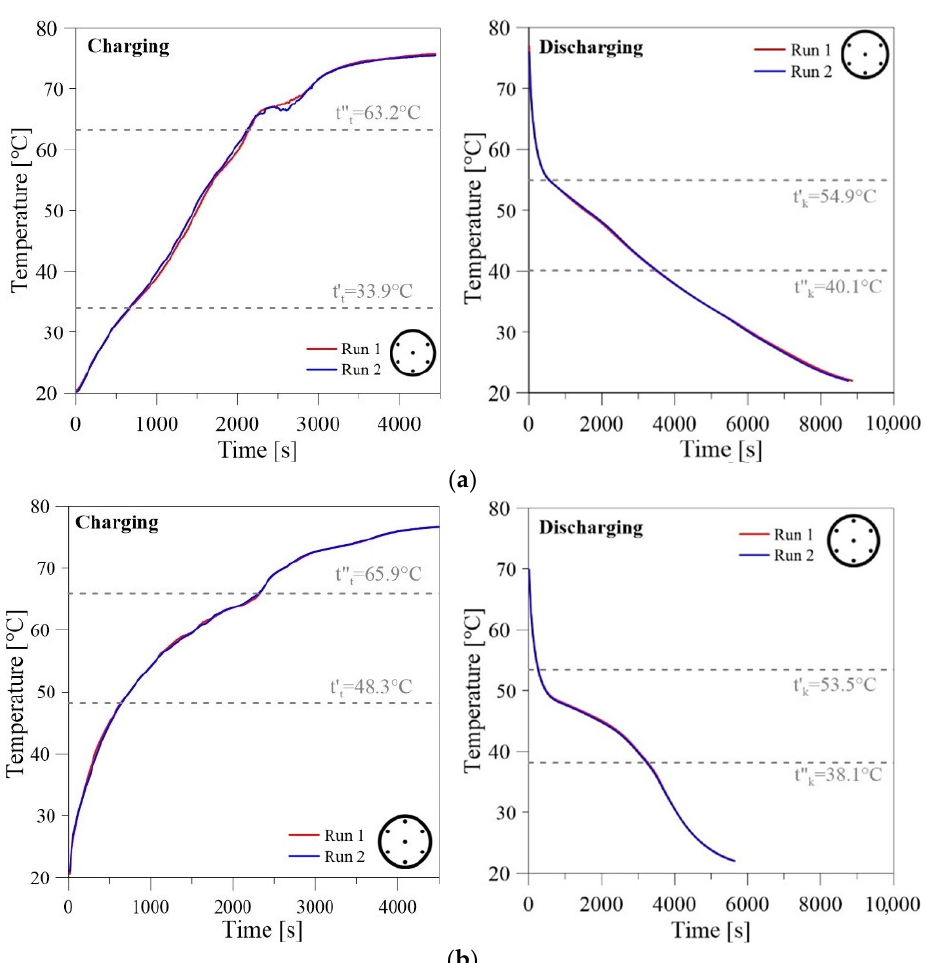
Figure 4. Repeatability of PCM temperature measurements: ( a ) LTP56; ( b ) P1808.